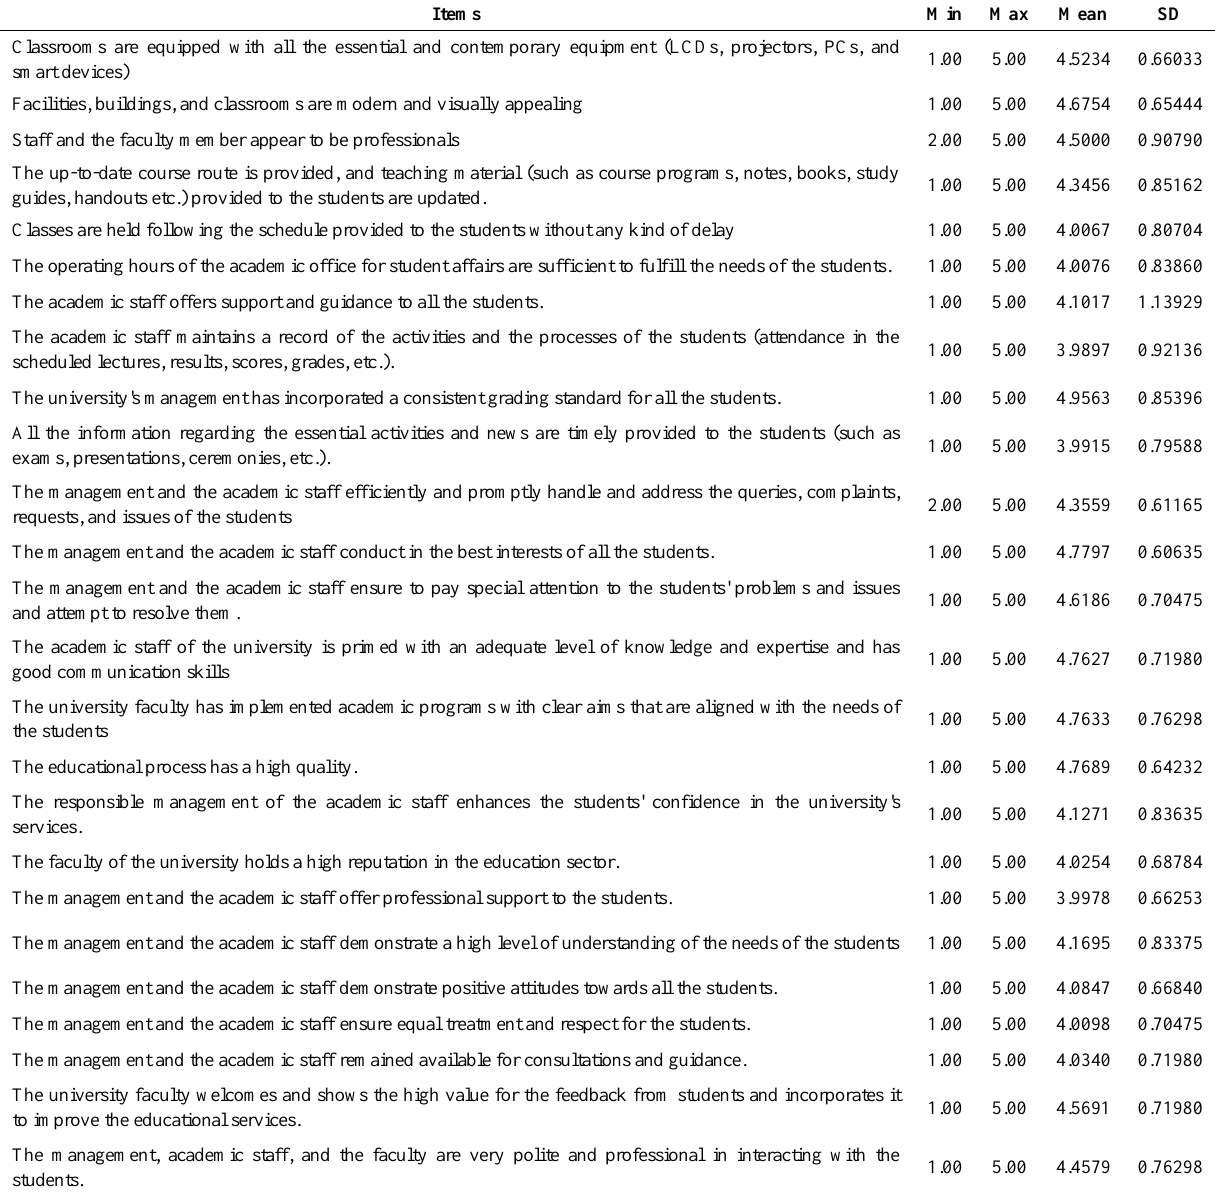
Table 7. Descriptive statistics for service quality perceptions of the students in Russia Items Min Max Mean